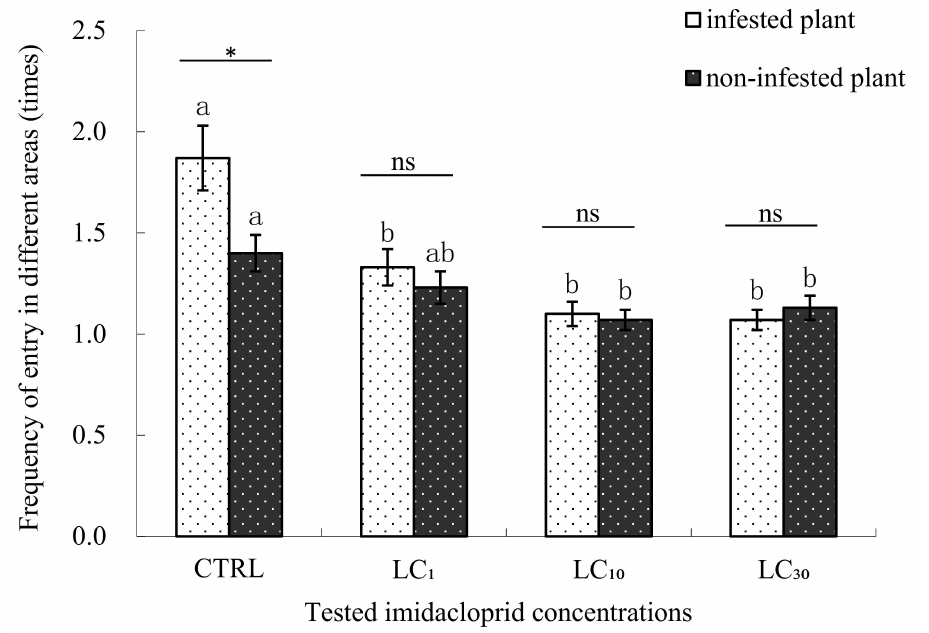
Figure 4. The frequency of Encarsia formosa entering different areas when treated with imidacloprid. Note: * p < 0.05 (significantly different between the two groups, t -test), ns (not significantly different between the two groups, t -test). The same letter over the bars of infested plant or non-infested plant areas indicates no significant differences between the various concentrations (Duncan’s multiple range test, α < 0.05). The “infested plant area” means cotton plants in the four-armed olfactometer infested with 3rd or 4th instar B. tabaci nymphs, while the “non-infested plants” means healthy cotton plants without whitefly infestation in the four-armed